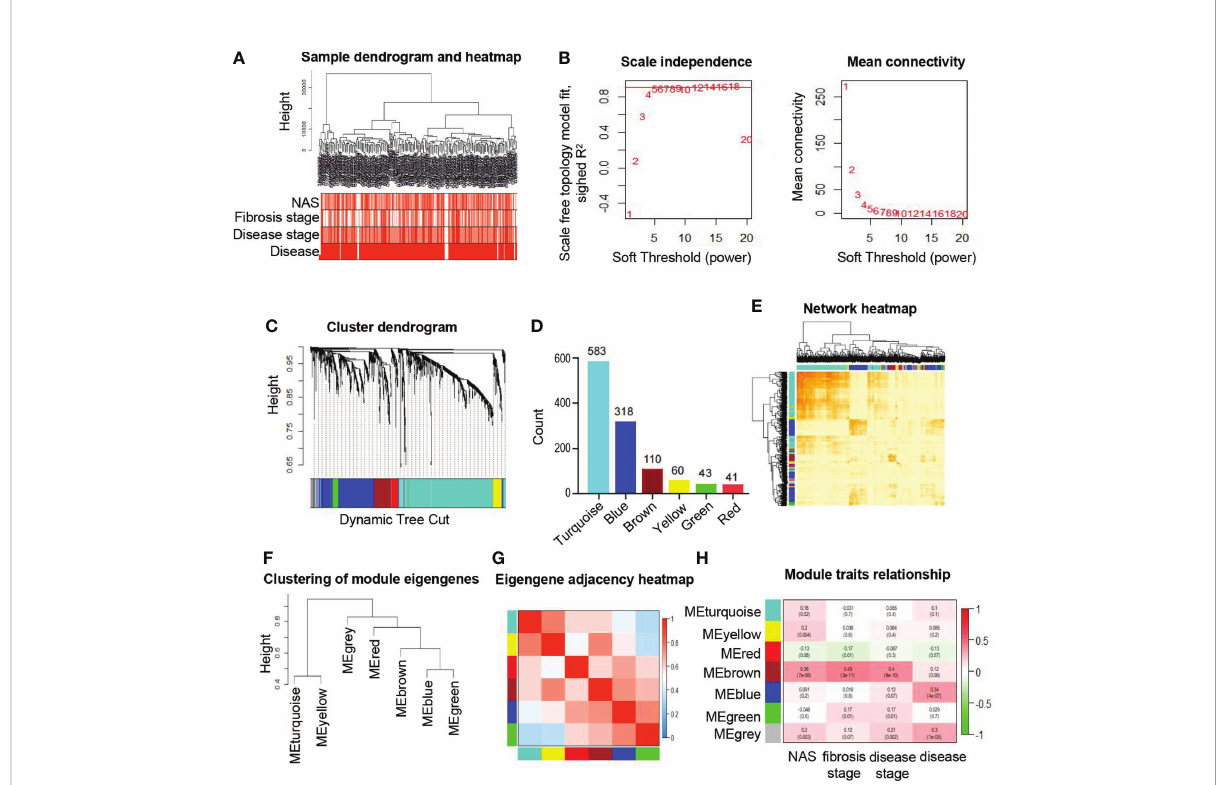
FIGURE 1 Identi fi cation and characteristic of key modules in ER related genes based on WGCNA. (A) Hierarchical clustering dendrogram of the samples and clinical traits. The color intensity is proportional to the properties of clinical traits including NAS (0-8), fi brosis stages (F0-F4), disease stages (control, early and moderate) and disease (NAFLD or not). (B) Soft threshold selection process to obtain the scale-free fi t index of network topology. (C) Hierarchical cluster tree shows six key modules based on WGCNA. The leaves in the tree represent genes and the colors underneath the dendrogram represent co-expression module determined by the dynamic tree cut. (D) Number of genes in each module. (E) Interaction of co-expression of genes based on TOM in the analysis. The progressively darker color in the heatmap represents higher topological overlap. Hierarchical clustering dendrogram (F) and heatmap (G) show the relationship among the six module eigengenes. Close branches of the dendrogram are highly correlated. In the heatmap, each row and column correspond to one module eigengene. Blue color represents low adjacency, while red represents high adjacency. (H) Correlation of module eigengenes and clinical traits. Each row represents module and each column represents corresponding clinical traits. Pearson correlation coef fi cients and P values are displayed and the boxes are colored according to the Pearson correlation coef fi cients. WGCNA, weighted gene co- expression network analysis; NAFLD, non-alcoholic fatty liver disease; TOM, topological overlap